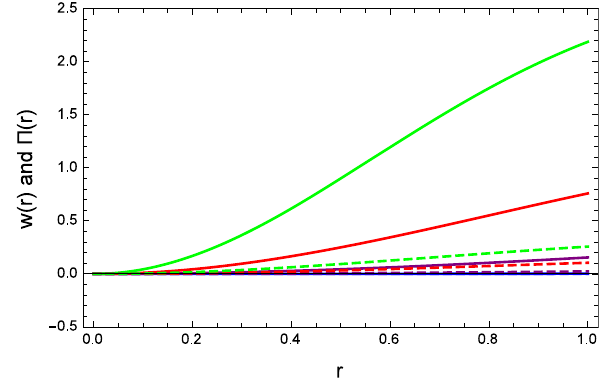
Fig. 5 w( r ) (solid lines) and Π( r ) (dashed lines) vs the radial coor- dinate r for fixed α = 1 and K = − 2 (Blue), K = − 20 (Purple), K = − 50 (Red), K = − 100